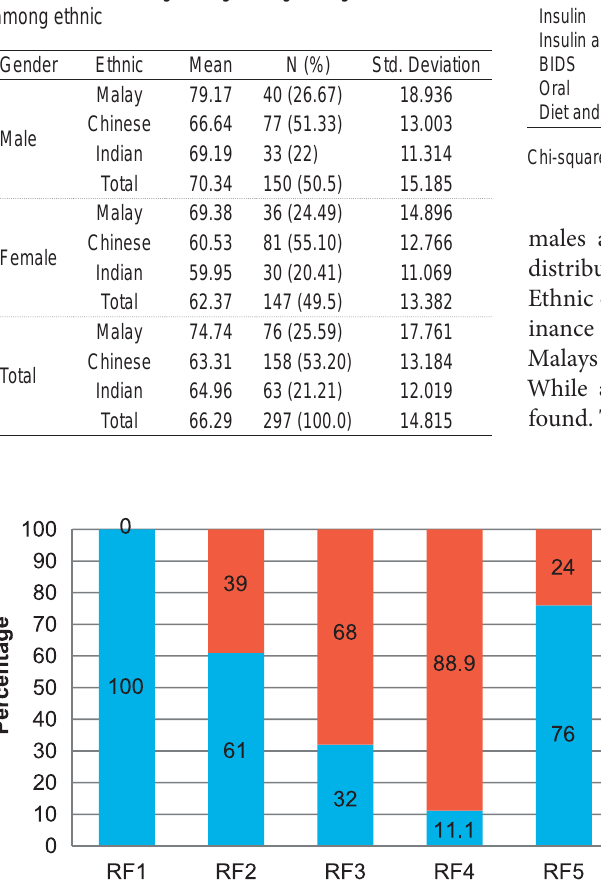
TABLE 3. Mean weight in kg at diagnosis gender